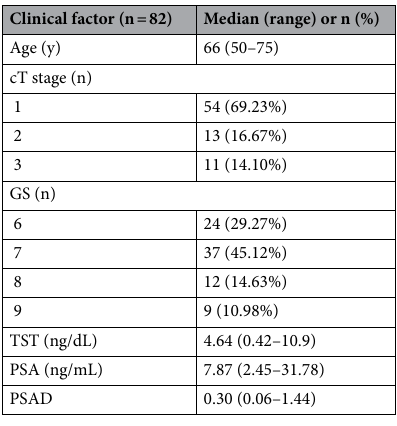
Table 1. Patients’ characteristics. cT stage = clinical tumour stage, GS = Gleason score, TST = testosterone, PSA = prostate-specific antigen, PSAD = PSA